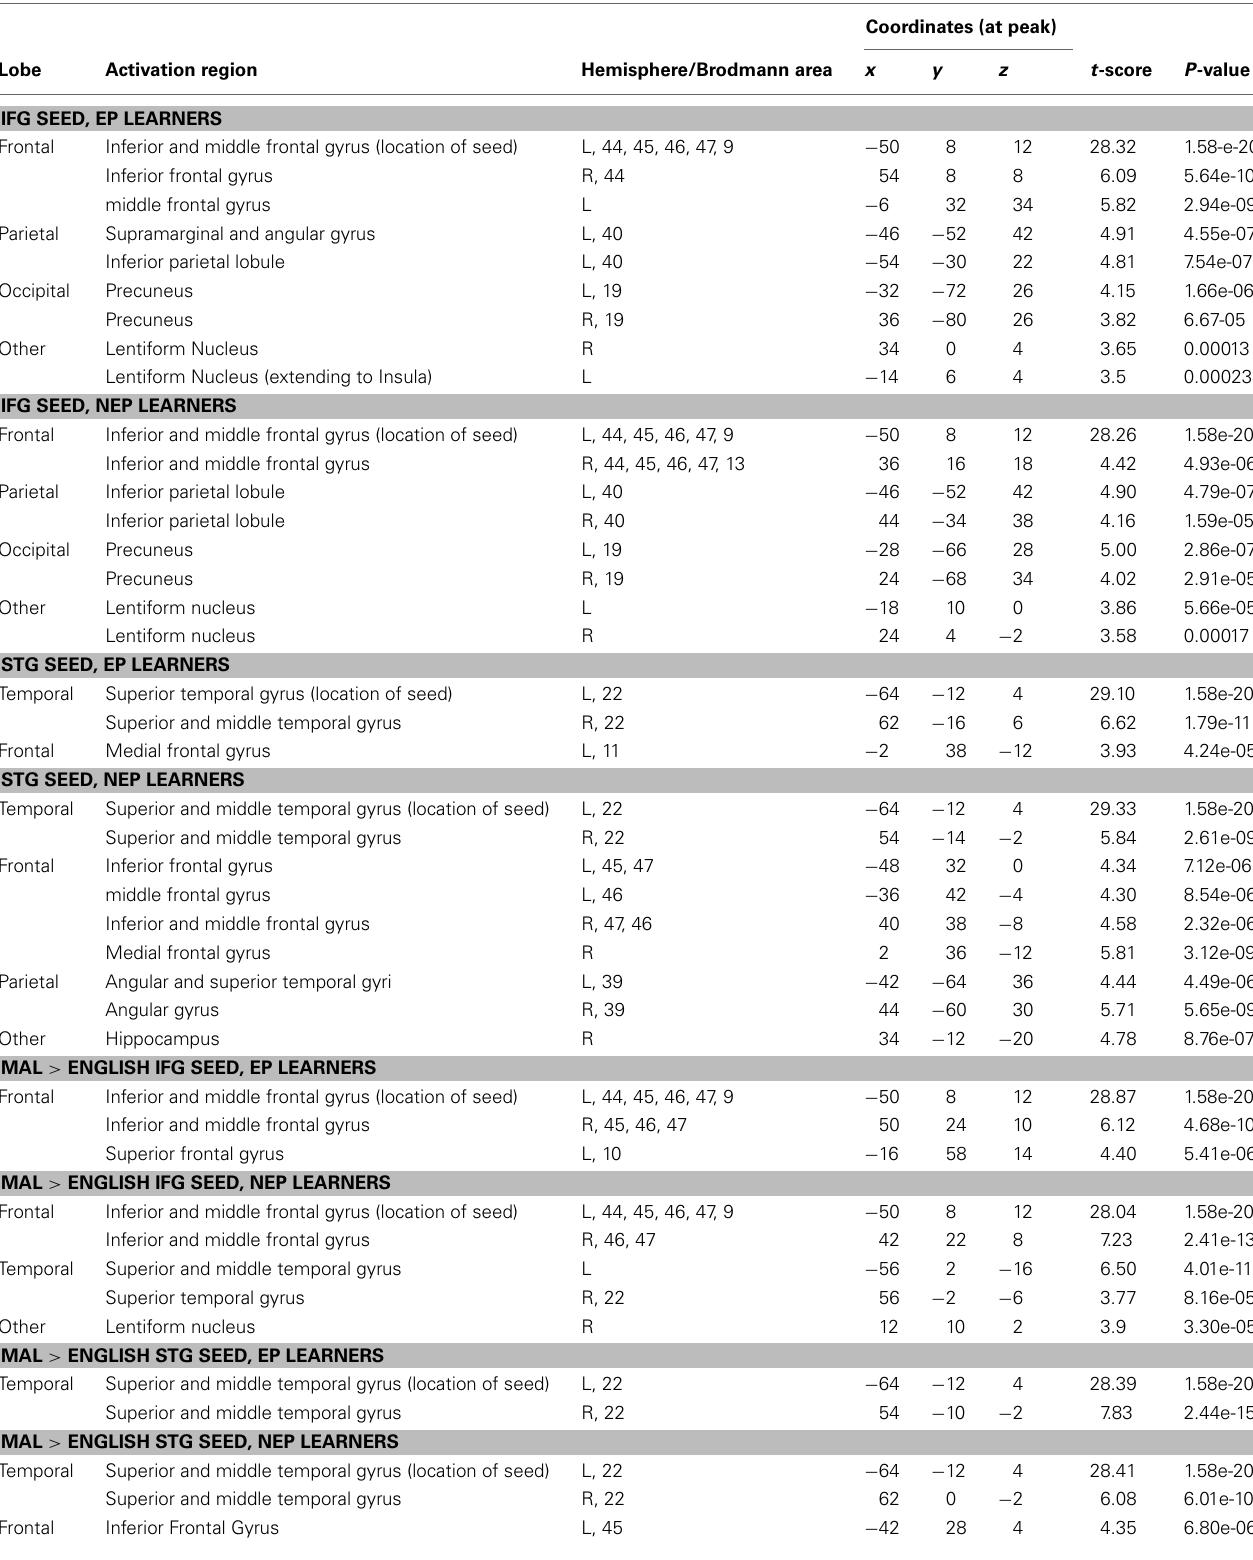
Table 8 | Beta series